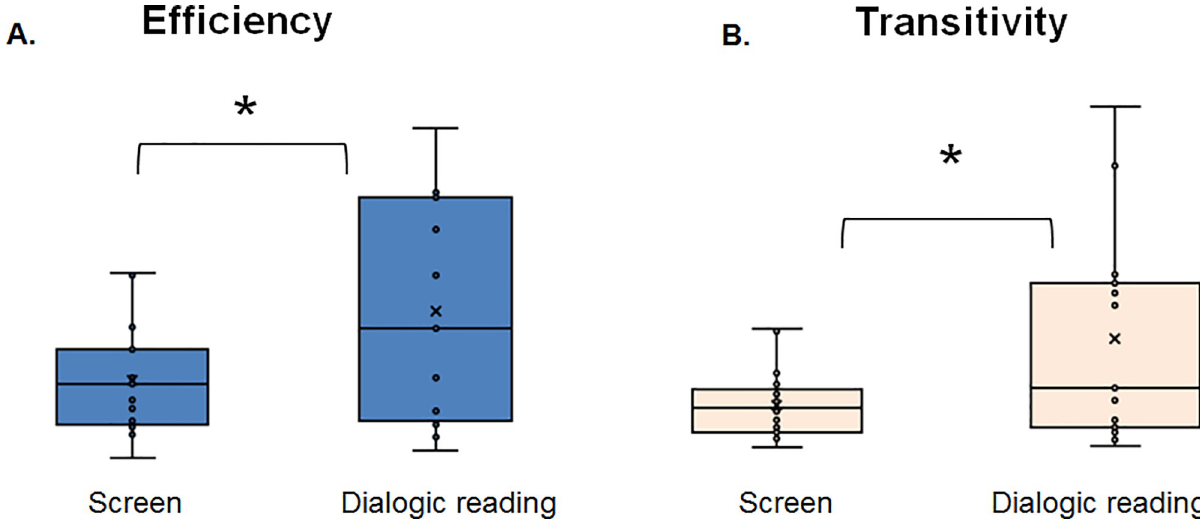
Fig 3. Network’s transitivity and efficiency in the dialogic reading and screen stories intervention groups. (A) Increased network’s transitivity (left panel) and (B) efficiency (right panel) for the screen stories group (Screen; right bar in each panel) compared to the dialogic reading group (Dialogic reading; left bar in each panel). � P <